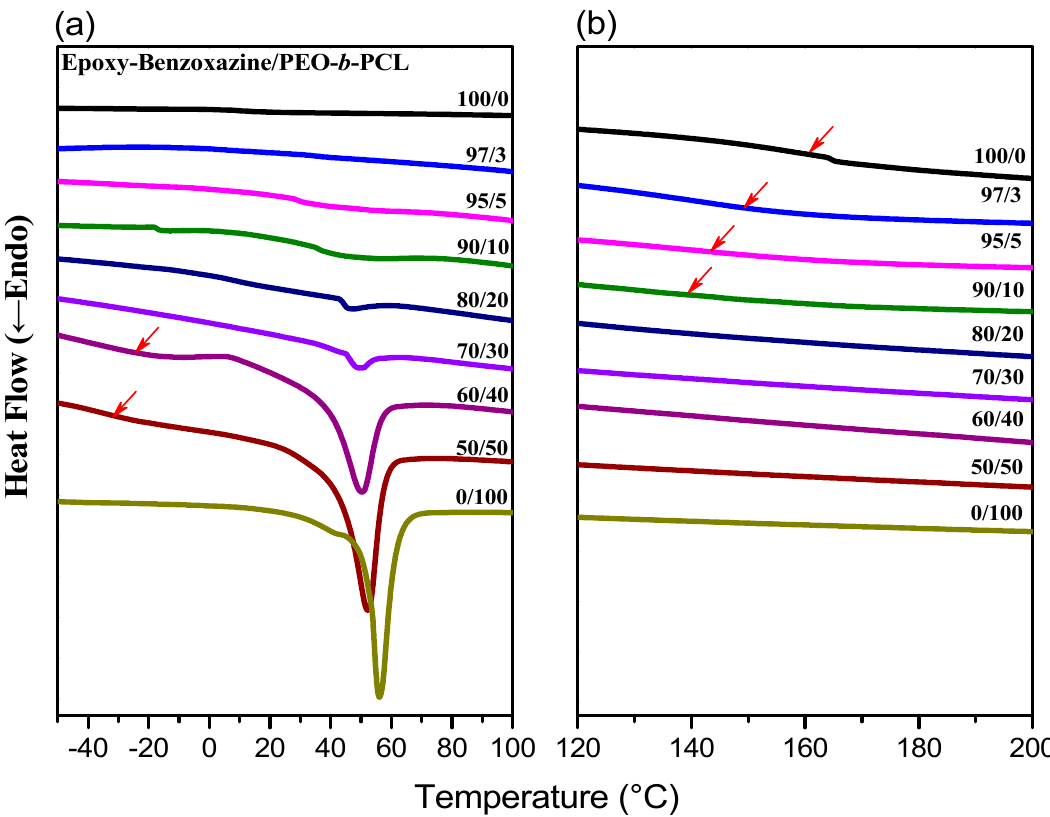
Figure 4. Differential scanning calorimetry (DSC) thermal analyses of epoxy–benzoxazine/PEO ‐ b ‐ PCL blends of various compositions (second heating scans), expanded from ( a ) –40 to +100 °C and ( b ) 120 to 200 °C.